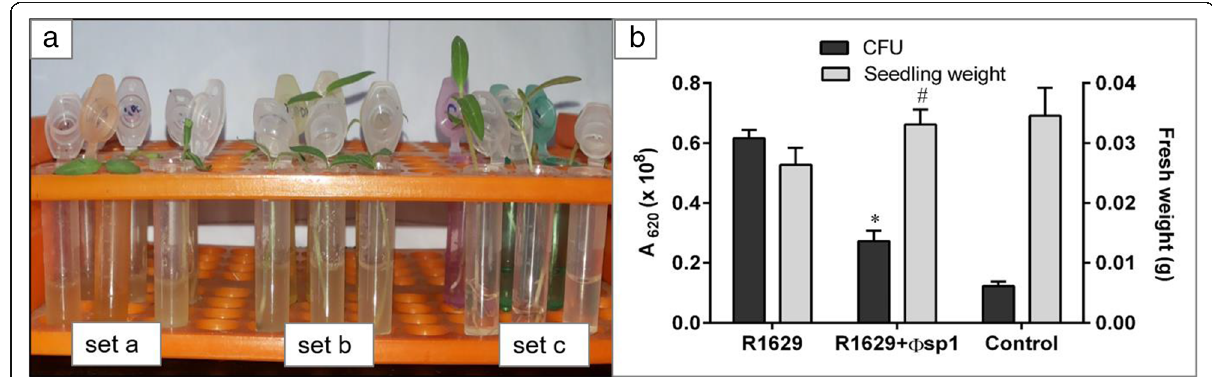
Fig. 4 Phage ɸ sp1 biocontrol assay of Ralstonia solanacearum strain 1629 (R1629) on tomato seedlings in vitro . a Phage ( ɸ sp1) biocontrol on tomato seedlings in microcentrifuge tubes; set a — R. solanacearum strain 1629 inoculated seedling wilted in 72 h, set b — R 1629 + ɸ sp1 (1 MOI) treated seedlings remained healthy, set c — uninoculated buffer control seedlings were found completely healthy. b Phage ɸ sp1 biocontrol efficacy on tomato seedlings after 72 h treatment. Primary axis shows reduced pathogen count (CFU) in phage ɸ sp1-treated R1629-infected tomato seedlings (R1629+ ɸ sp1) compared to phage untreated, R1629-infected tomato seedlings (* p ≤ 0.0024). Secondary axis shows fresh weight of tomato seedlings in R1629 + ɸ sp1-treated and phage-untreated R1629-infected tomato seedlings (# p ≤ 0.031). Data are mean values of experiment performed in triplicates with standard